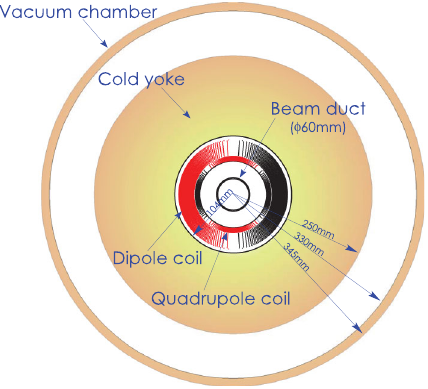
FIG. 6. Cross-sectional view of the superconducting magnets for BM1-BM6.